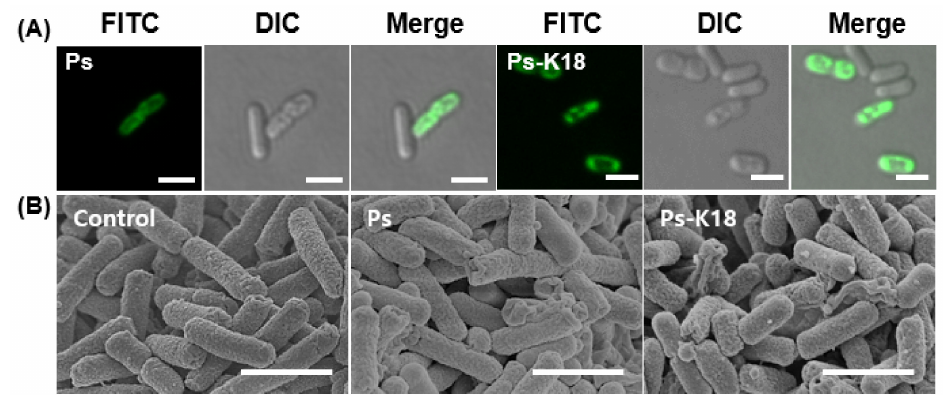
Figure 2. Confocal and scanning electron micrographs of E. coli treated with Ps and Ps-K18. ( A ) Confocal micrographs of Ps and Ps-K18 at a 1 × MIC after 1 h incubation. The scale bar is 2 µ m. ( B ) FE-SEM micrographs of control, no peptide treatment, and Ps and Ps-K18 (1 × MIC) after 4 h incubation. The scale bar is 2 µ